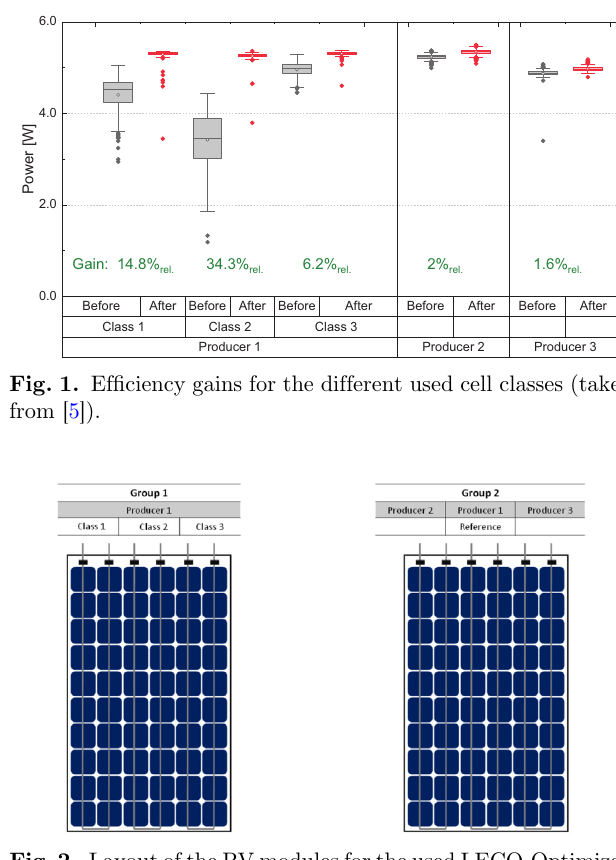
Fig. 2. Layout of the PV modules for the used LECO-Optimized solar cells (taken from